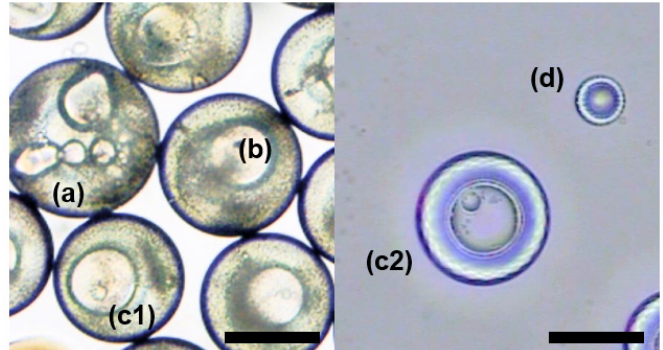
Figure 6. Droplets of different sizes. Droplets were denoted as ( a – c ) and ( d ) from big to small, in which ( c1 ) was the same size as ( c2 ). (a) was a microsphere with many small cores; ( b ) was a microsphere with two layers; ( c1 ) and ( c2 ) were microspheres with three layers; ( d ) was a single emulsion. The scale bar is 200 µm.